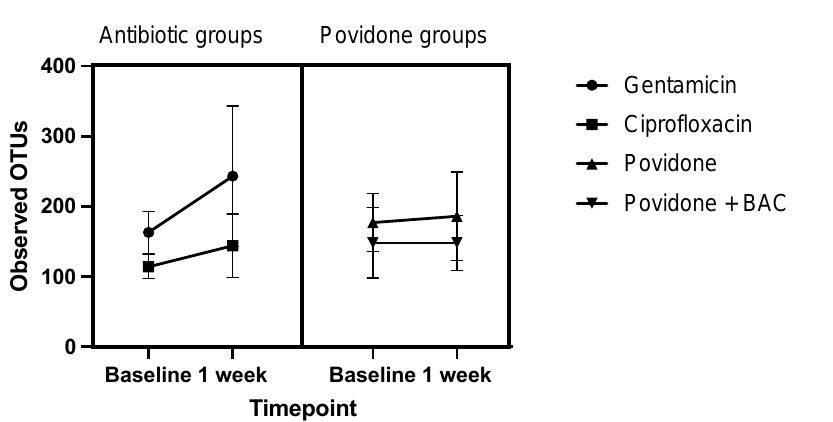
Figure 1. Microbial richness in nasal samples. Comparison of OTUs before and after treatment (Baseline: before instillation of eye drops, 1 week: after 7 days’ instillation). Sequences are clustered according to their similarity to another. Group 1 received gentamicin eye drops, group 2 received ciprofloxacin, group 3 received topical lubricants containing povidone only, group 4 received topical lubricants containing povidone and BAC.